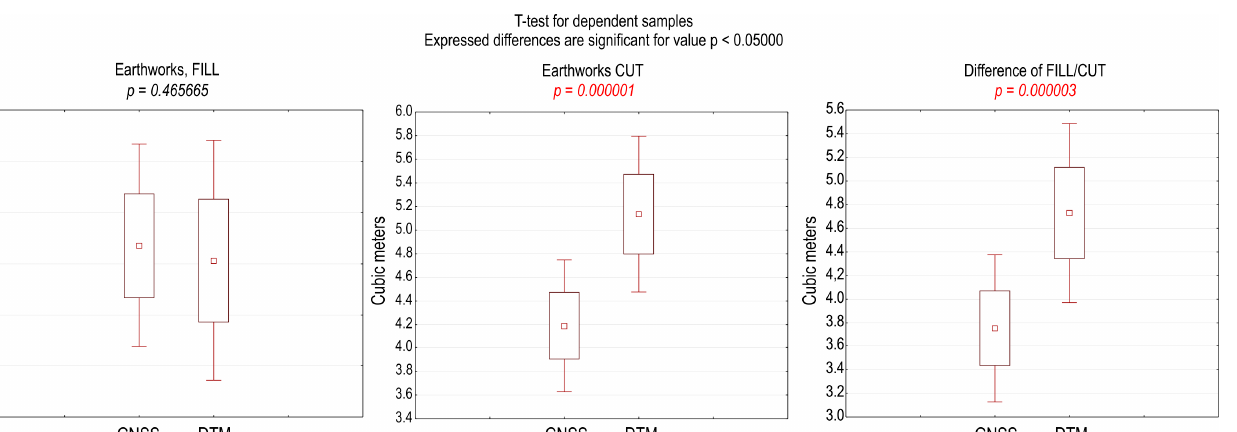
Table 5. Summary data on earthworks of Fill and Cut on the designed forest/skid road.